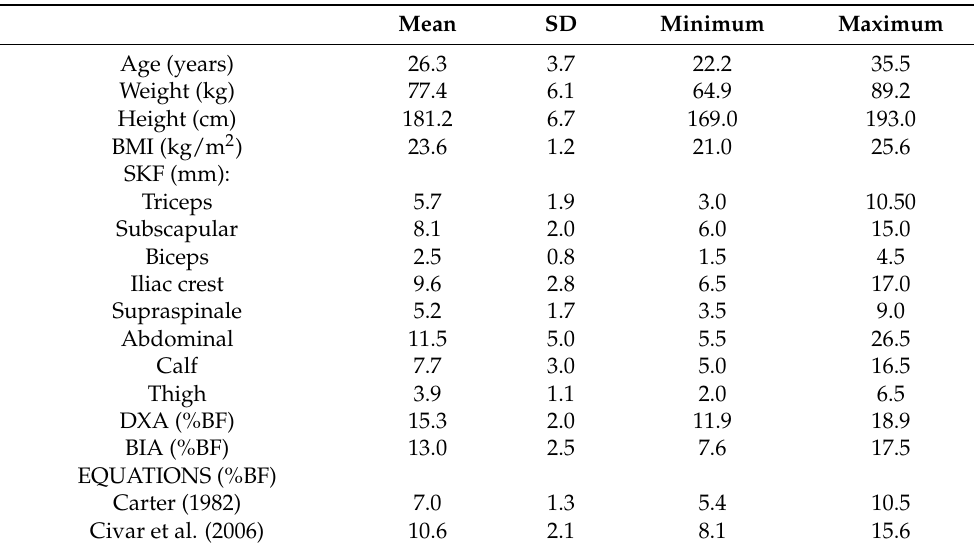
Table 1. Subject characteristics and body fat percentages estimated using the methods DXA, BIA, anthropometric equations and absolute SKFs in elite soccer players ( n =